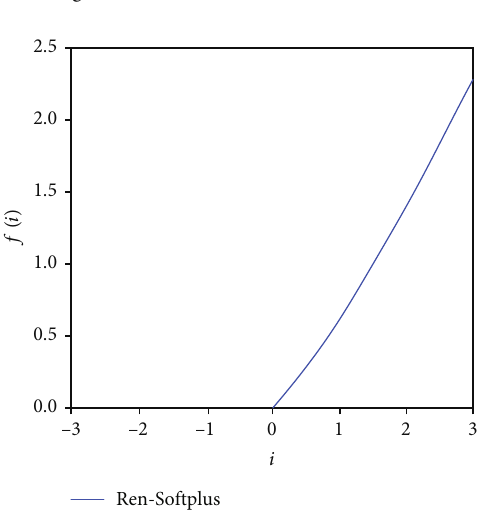
Figure 5: Activation function of